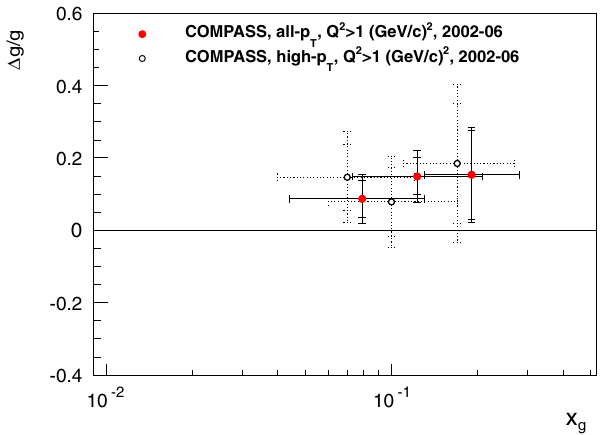
Fig. 5 Thenewresultsfor (cid:3) g / g inthree x g binscomparedtoresultsof Ref.[11]( leftpanel )andworlddataon (cid:3) g / g extractedinLO[8–10,12] ( right panel ). The inner error bars represent the statistical uncertainties